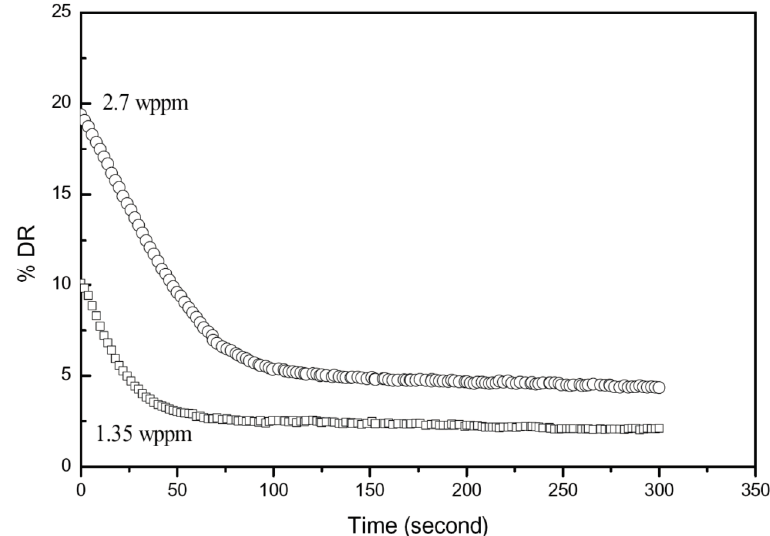
Figure 8. Drag reduction versus time with λ -DNA and different concentrations (Reprinted